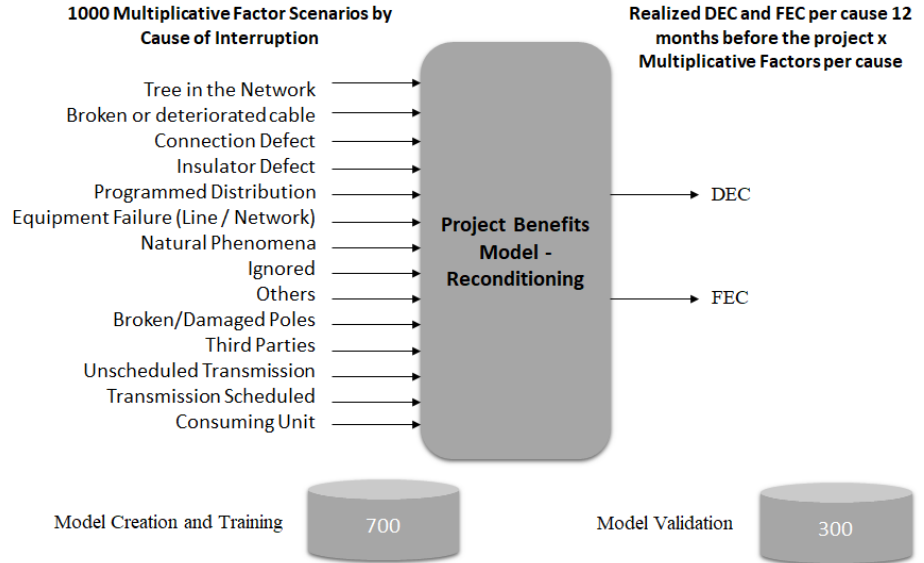
Figure 3. Inputs and outputs of the ANN model.